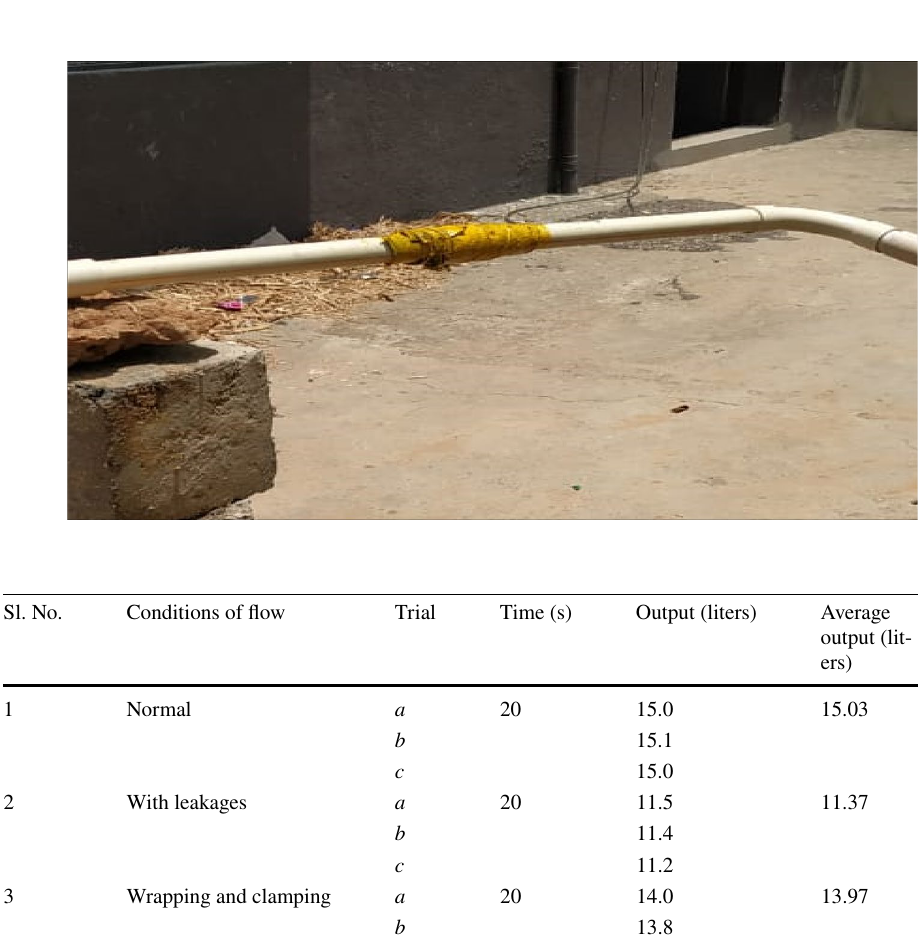
Fig. 6 wrapping using polymer rubber